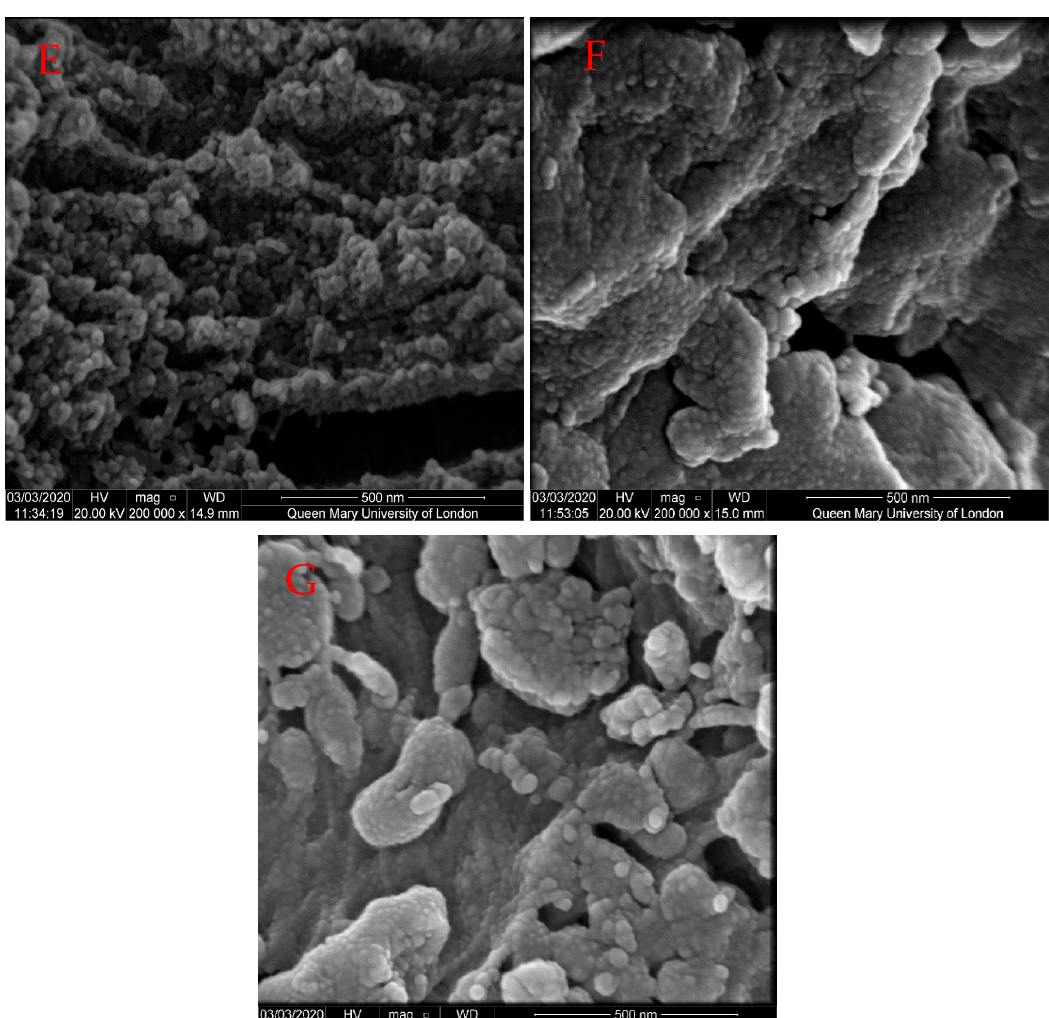
Figure 2. SEM images of raw SPB and chars after di ff erent reaction times at di ff erent temperatures.